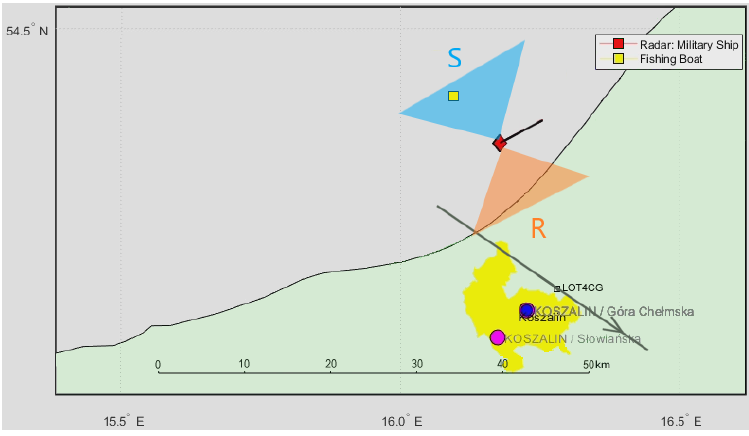
Figure 26. Situation map for the LOT4CG airplane (EMBRAER 175).